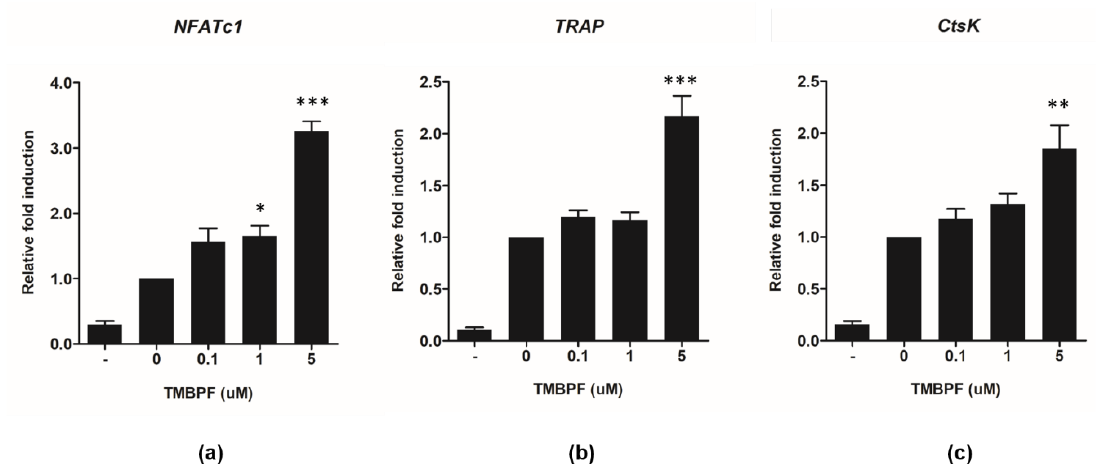
Figure 4. TMBPF activates osteoclast-specific gene expression. RAW 264.7 cells were incubated with RANKL (50 ng/mL) with various concentrations of TMBPF (0.1, 1, 5 μM). (-) group refers to no RANKL treatment. The expression levels of osteoclasts-related marker genes, including ( a ) NFATc1 , ( b ) TRAP , and ( c ) CtsK , were detected by qRT-PCR. Results were normalized to the expression of β -actin. * p < 0.5, ** p < 0.01, *** p < 0.001 vs. 0 group.